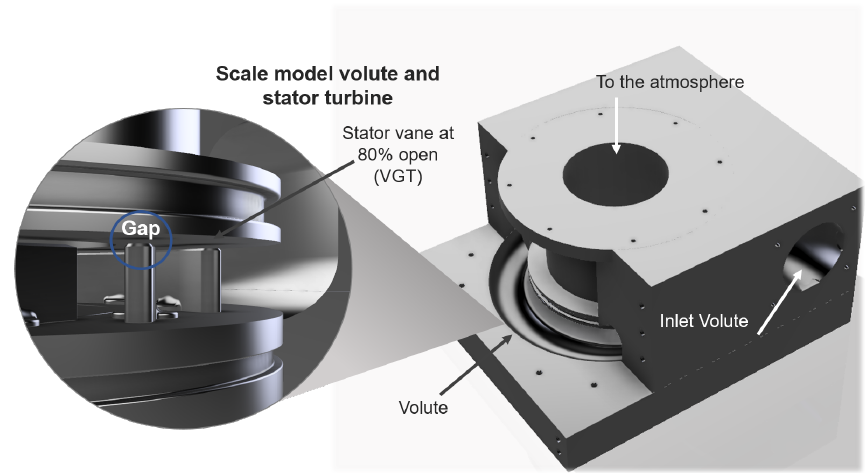
Figure 1. Scaled 3:1 turbine model.